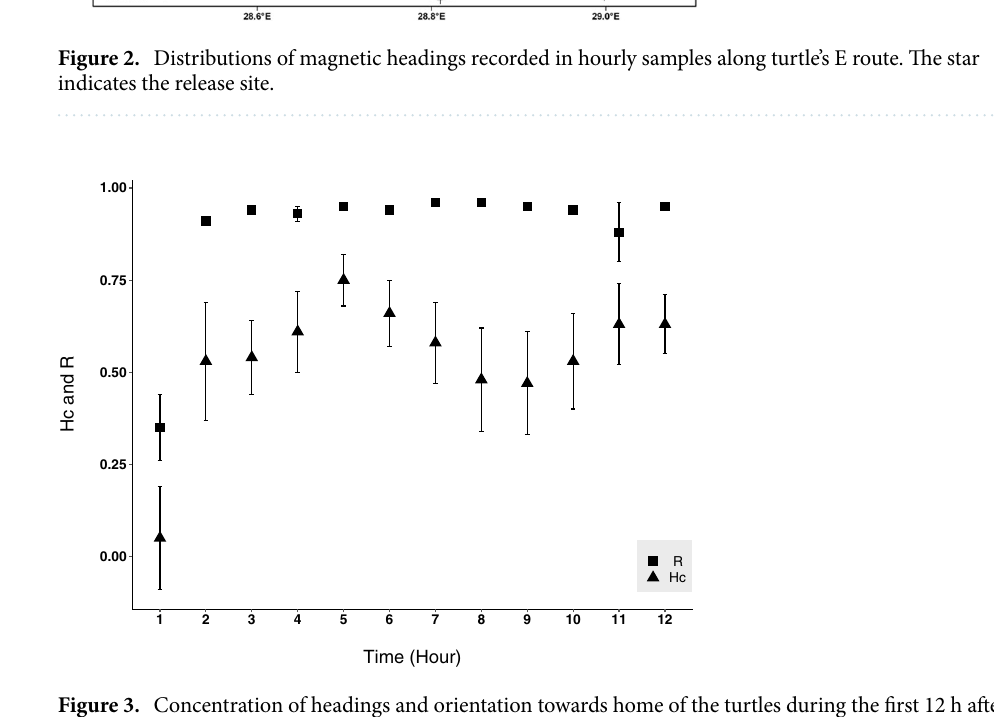
Figure 3. Concentration of headings and orientation towards home of the turtles during the first 12 h after release. Data shown are mean + /− SEM of vector length (R, squares) and homeward component (Hc, triangles) averaged for the six turtles calculated for hourly samples of magnetic headings (3600 headings each). Homeward components of the same samples express the turtle tendency to orient towards the home direction. Home direction for successive samples was computed by measuring the directions of hourly-interpolated Argos